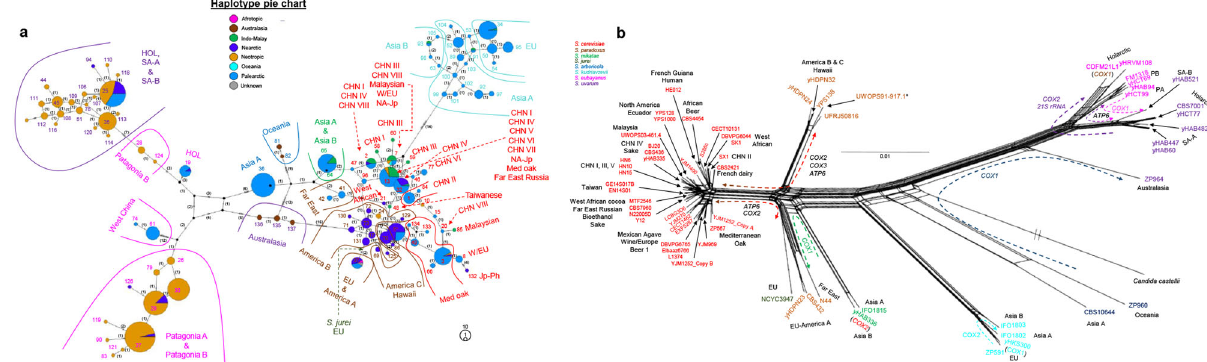
Fig. 2 | Extensive mitochondrial gene fl ow and introgression between Sac- charomyces lineages.a Templeton,Crandall,andSing(TCS)phylogeneticnetwork of 739 partial COX2 sequences from wild Saccharomyces strains. COX2 haplotype classi fi cation, for the wild and anthropic Saccharomyces strains ( n =1774 COX2 sequences), is shown in Supplementary Data 1. Haplotypes are represented by circles. The circle size is scaled according to the haplotype frequency. Pie charts show the frequencyof haplotypes based on the biogeographicrealm. The number of mutations separating each haplotype are indicated by lines on the edges con- necting different haplotype circles and by numbers between parentheses. Haplo- type numbers and populations are highlighted in the panel and colored according to species designations. CHN China, EU Europe, HOL Holarctic, Jp-Ph Japan-Phi- lippines (=Sake-Philippines), Med oak Mediterranean oak, NA-Jp North America- Japan(=NorthAmerica),SA-ASouthAmericaA,SA-BSouthAmericaB,W/EUWine/ European. b Neighbor-Net phylogenetic network reconstructed using a con- catenated alignment of the coding sequences of ten mitochondrial genes ( ATP6 , ATP8 , ATP9 , COB , COX1 , COX2 , COX3 , VAR1 , and the genes encoding 15S rRNA and